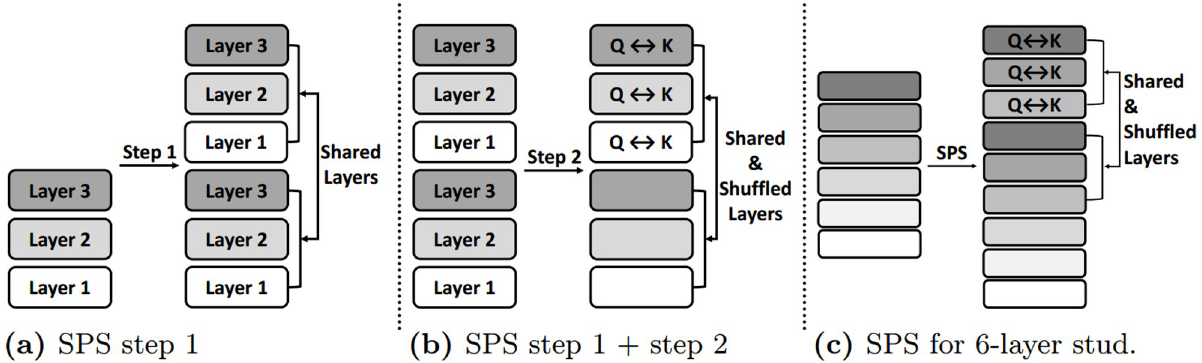
Fig 1. Graphical representation of SPS. Each figure represents (a) first step of SPS (b) second step of SPS, and (c) modified SPS for a 6-layer student, respectively.